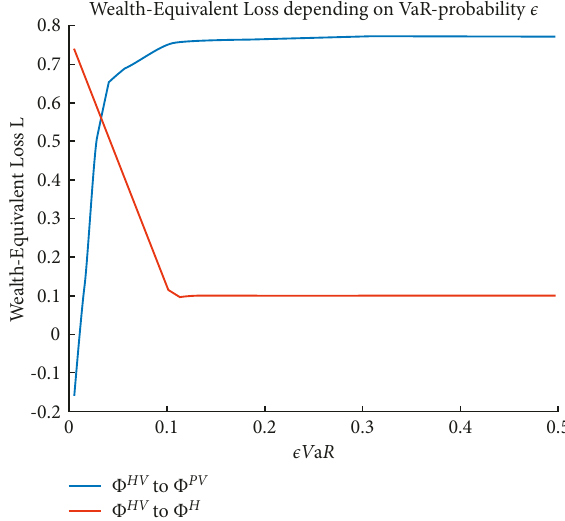
Figure 6: Wealth-equivalent loss sensitivity to μ